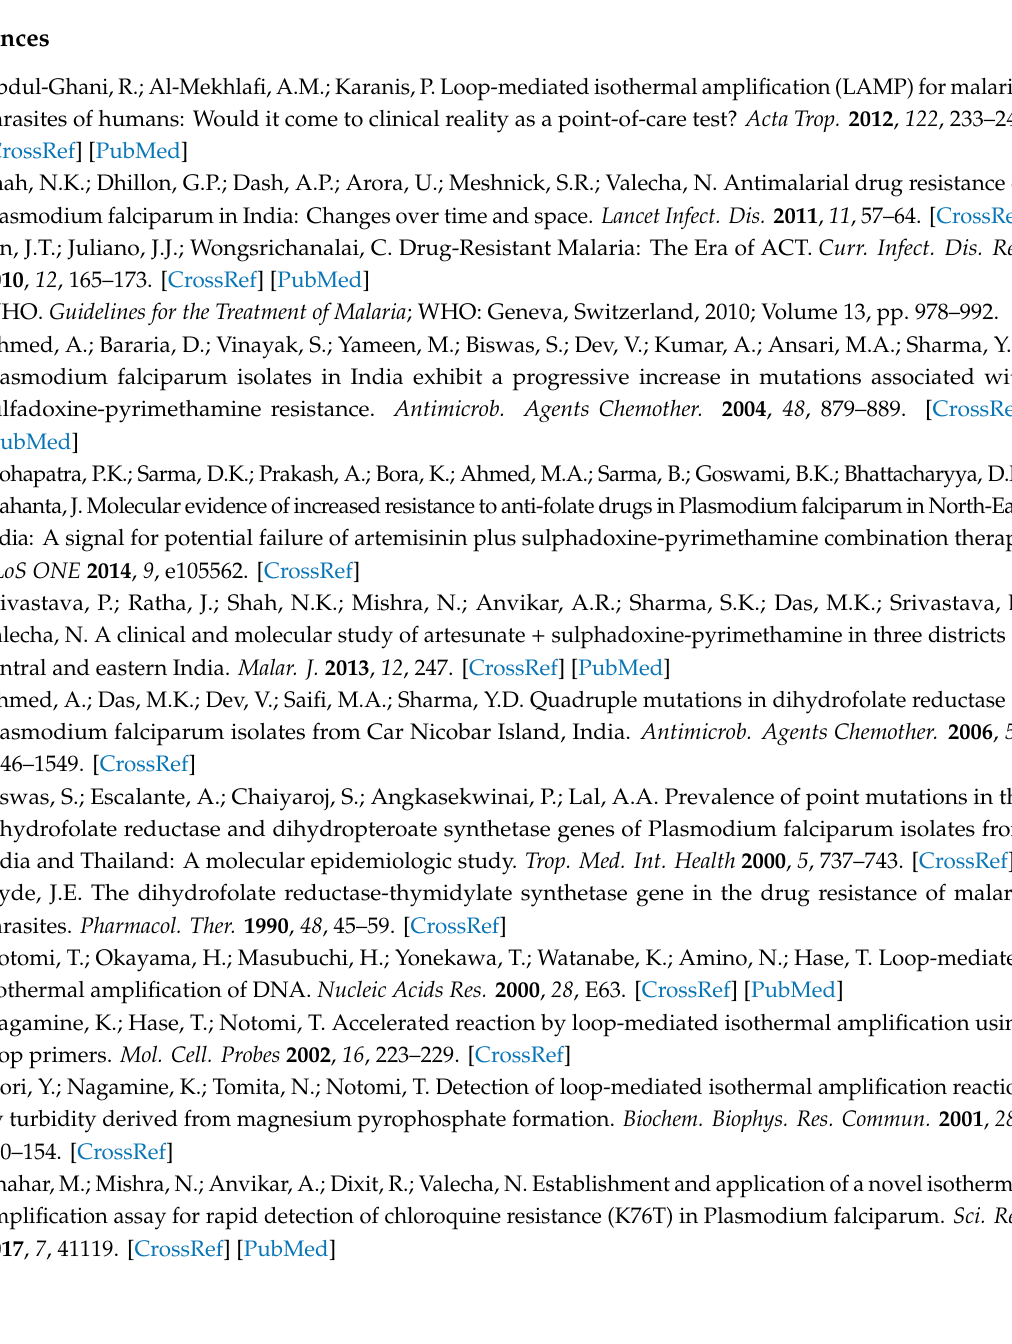
Table S1: List of P. falciparum samples used in the repeatability test of SNP-LAMP for the fast detection of pyrimethamine resistant mutants (S108N) and their corroboration by gold standard sequencing